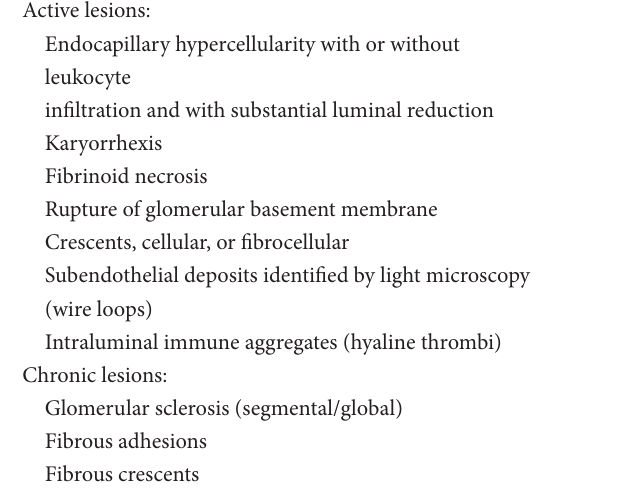
Table2:Activeandchronicglomerularlesionsspecifiedbythe2004 ISN/RPS lupus nephritis